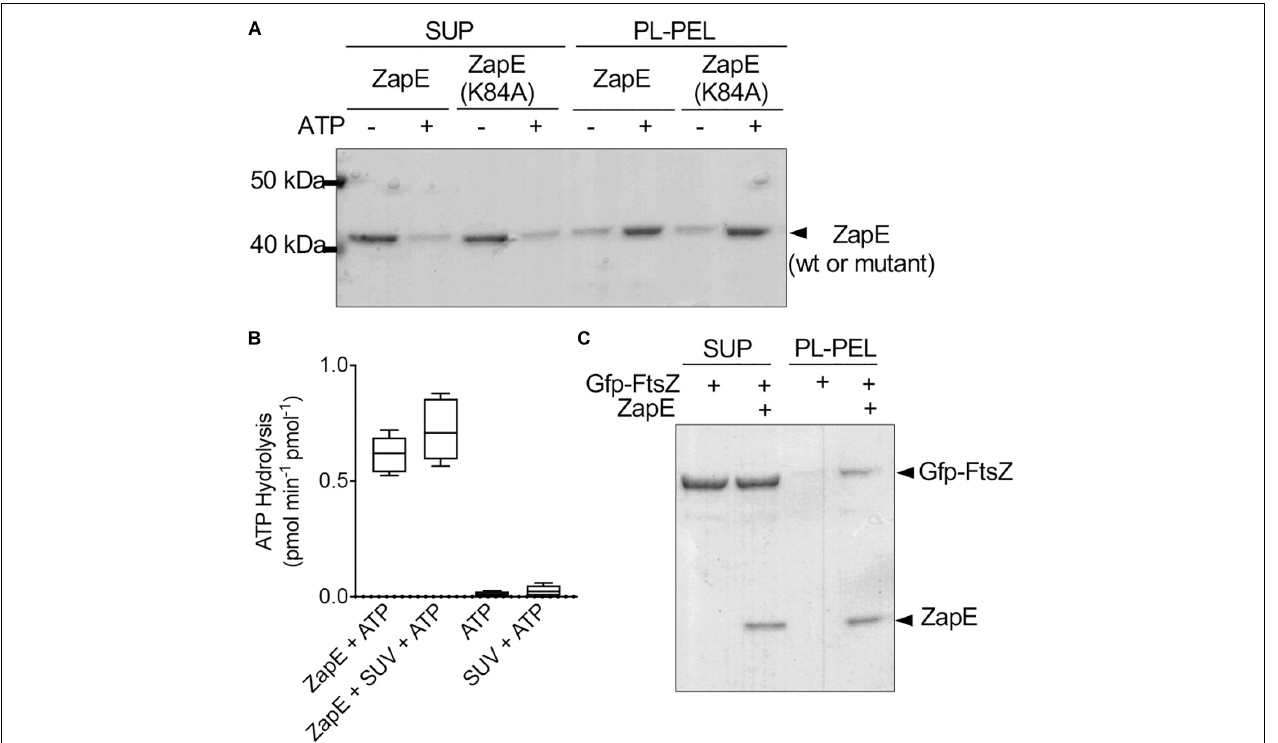
FIGURE 3 | ZapE recruits FtsZ to phospholipid (PL) vesicles in vitro . (A) ZapE (1 µ M) or, where indicated, ZapE(K84A) (1 µ M), was incubated with E. coli PL vesicles (500 µ g ml − 1 ) in the absence or presence of ATP (4 mM). PL-associated protein was collected by low-speed centrifugation. Supernatants and pellets were analyzed by SDS-PAGE. Data shown are representative of at least three replicates. (B) ATP hydrolysis assays were performed in the presence of PL vesicles in reactions containing ZapE (6 µ M), ATP (4 mM), and PL vesicles (250 µ g ml − 1 ). Data shown are the average of at least three replicates represented as mean ± SEM. (C) Gfp-FtsZ (3 µ M) was incubated with GTP (4 mM) and added to PL vesicles (500 µ g ml − 1 ) with and without ZapE (1 µ M) and ATP (4 mM). PL-associated protein was collected by low-speed centrifugation. Supernatants and pellets were analyzed by SDS-PAGE. Data shown are representatives of at least three